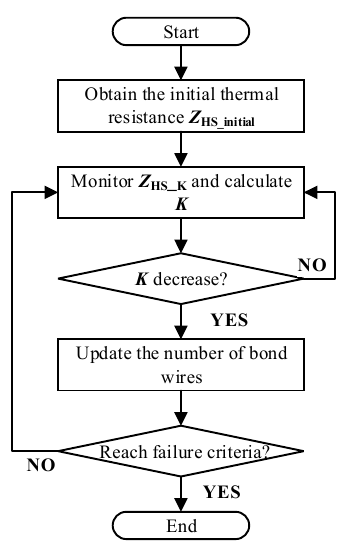
Figure 5. Flowchart of the fault detection method of bond wires.